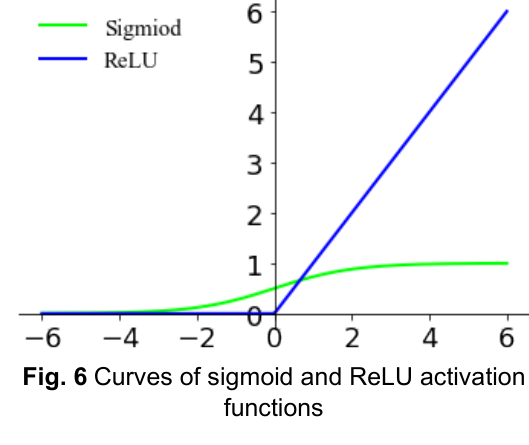
Fig. 6 Curves of sigmoid and ReLU